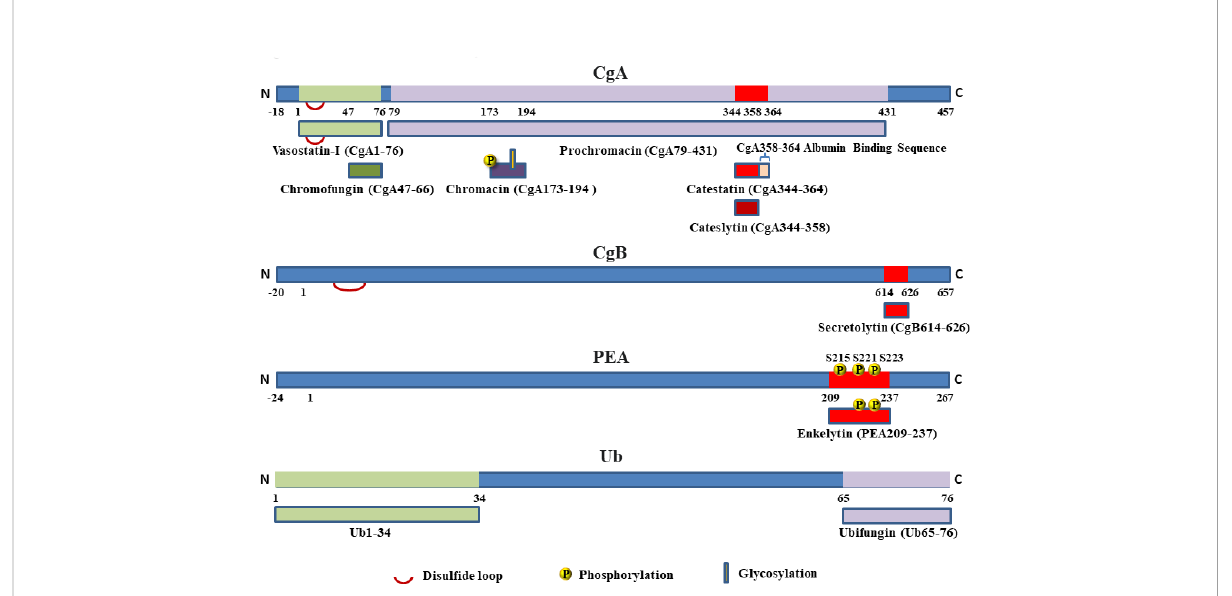
FIGURE 1 AMPs derived from the natural processing of Chromogranins Cgs (CgA and CgB), proenkephalin-A (PEA) and free ubiquitin